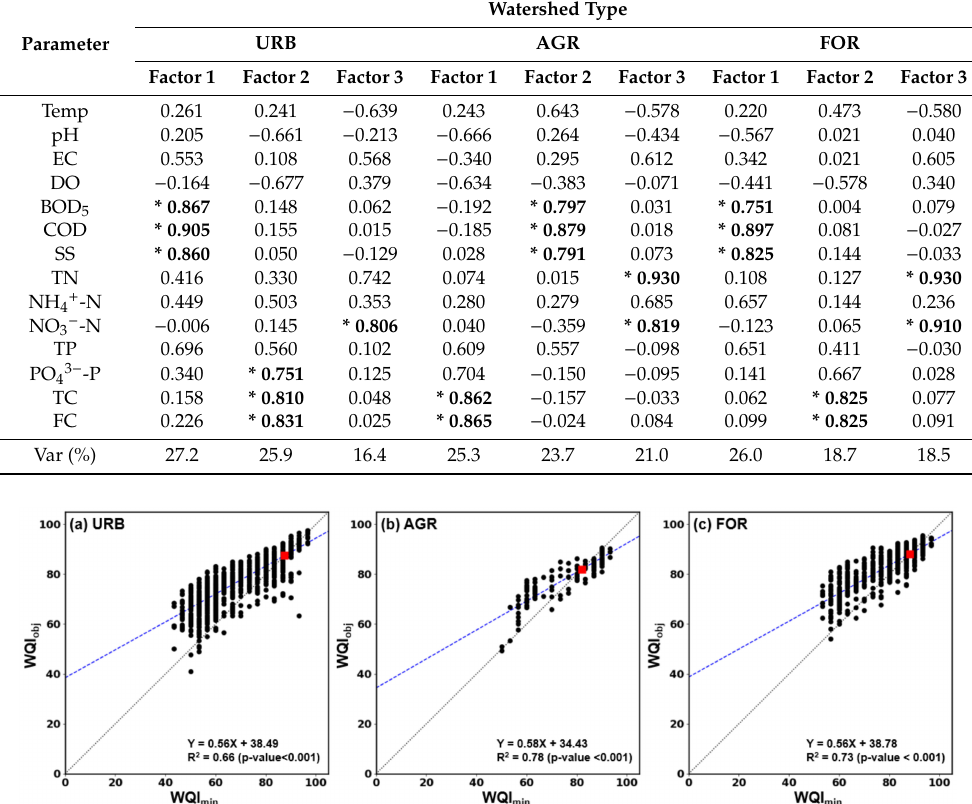
Figure 4. Relationships between objective water quality index (WQI obj ) and minimum WQI (WQI min ) for watersheds with, ( a ) urban-dominated, ( b ) agriculture-dominated, and ( c ) forest-dominated land use. Black circles denote WQI values calculated using the testing data set (2017–2018). Black dotted and blue dashed lines represent one-to-one, and regression lines, respectively. Red square represents the point of intersection between the one-to-one line and regression